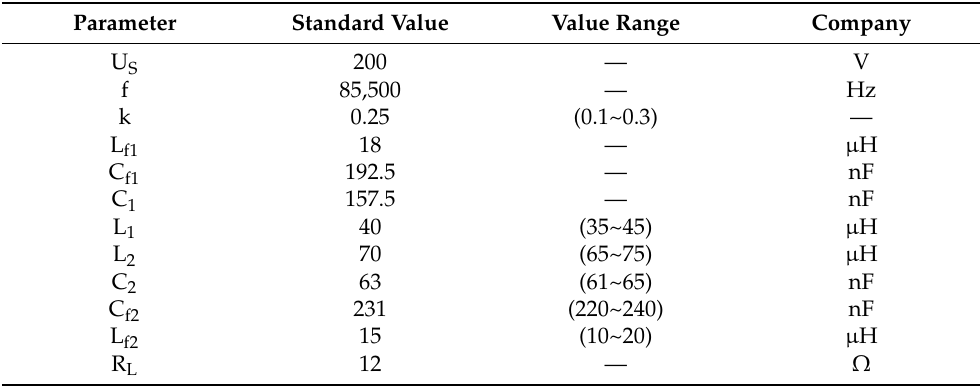
Table 3. System simulation